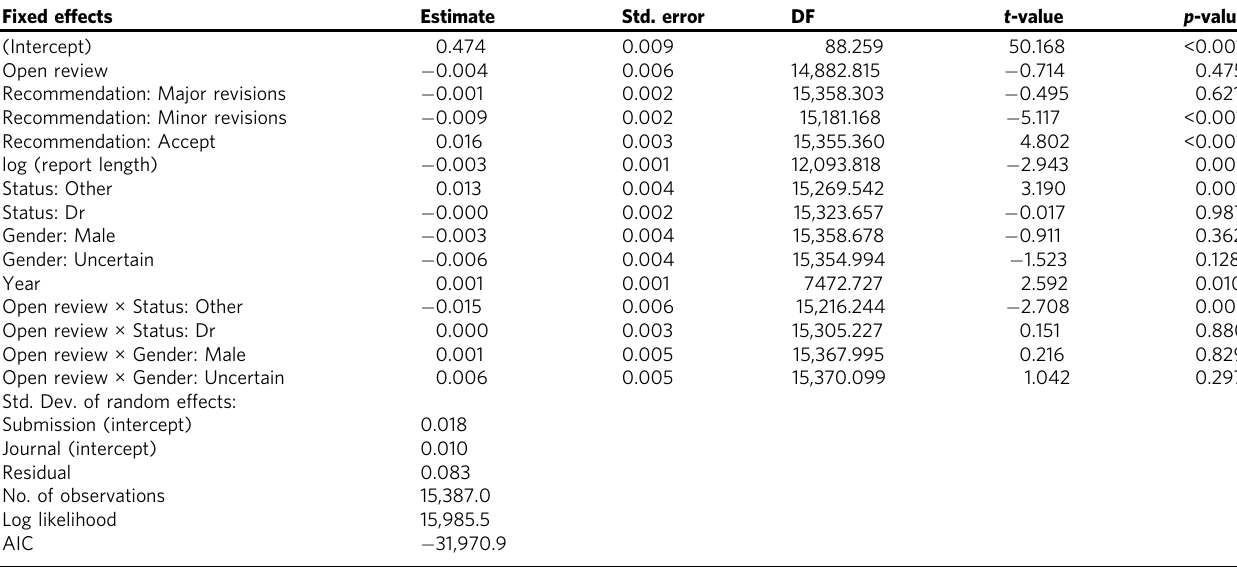
Table 5 Mixed-effects linear model on the subjectivity of the review